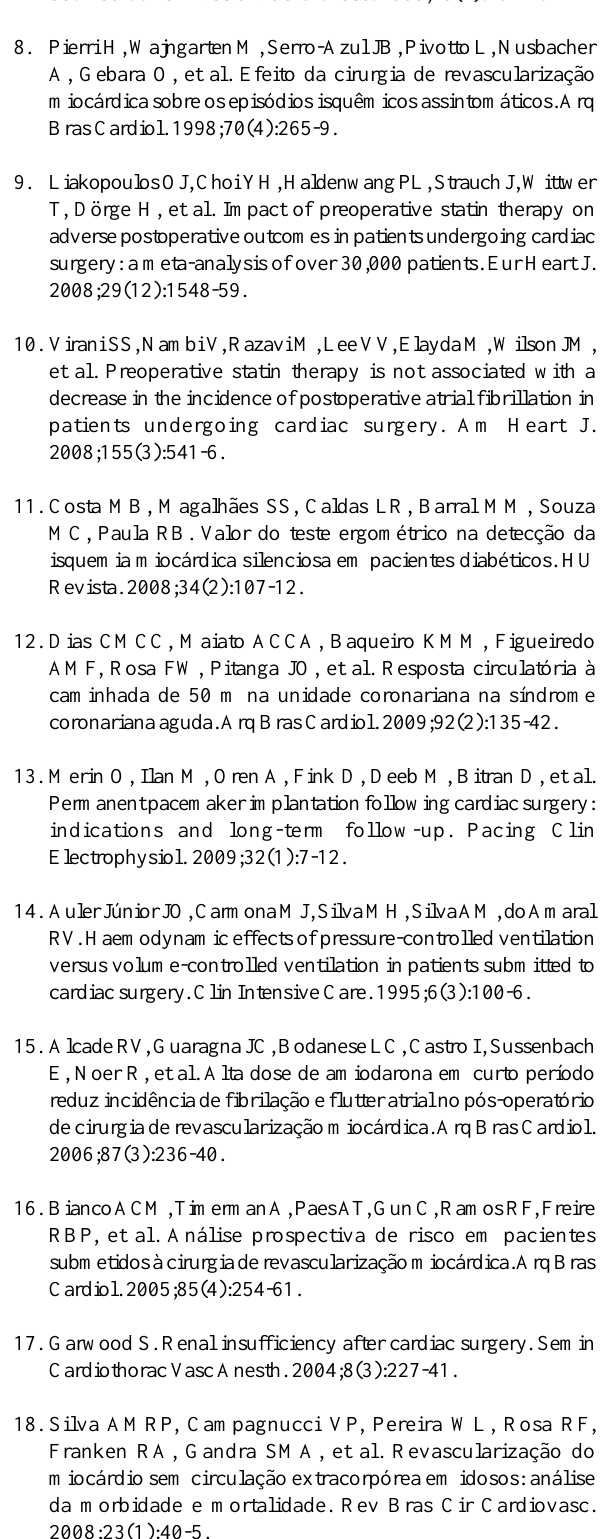
protocolo da via rápida. Arq Bras Cardiol. 2004;83(1):18-26. 6. Olmos SC, Granço BM, Oliveira SP, Figueiredo LC, Sasseron AB, Cardoso AL, et al. Tempo de internação hospitalar relacionado à fisioterapia respiratória no pré-operatório de cirurgia cardíaca eletiva. Arq Med ABC. 2007;32(Supl 2):S23-5. 7. Campagnucci VP, Silva AMRP, Pereira WL, Chamlian